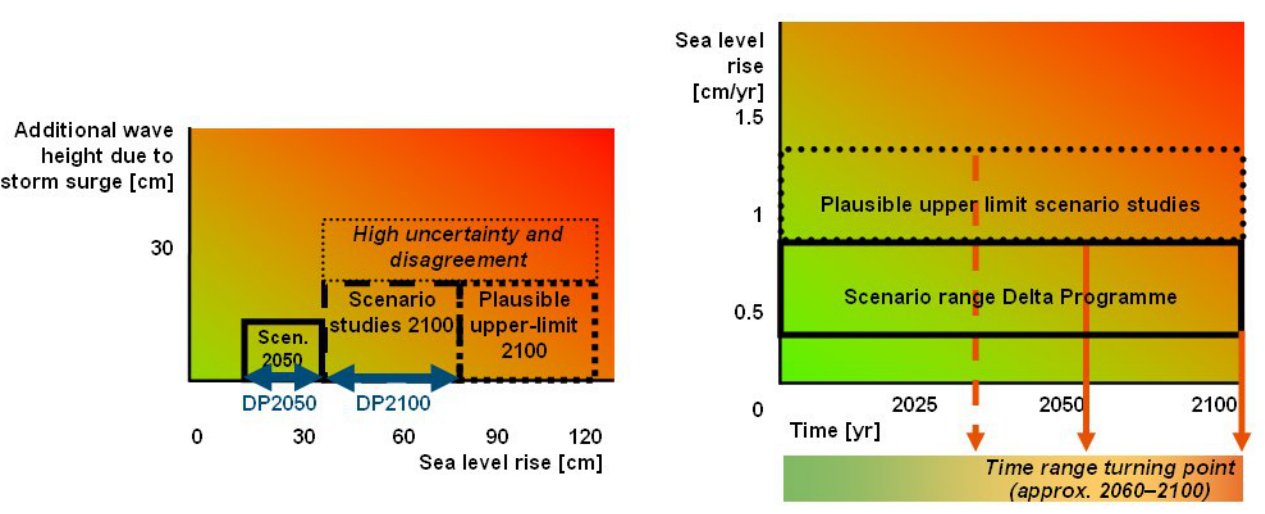
Fig. 4 . Adaptation turning point for the Wadden Sea. (a) Probability that the primary sea walls will fail to meet the norms because of a combination of sea level rise and additional storm surge (left). (b) Probability of unacceptable loss of mudflats because of sea level rise, with green indicating low probability and red indicating high probability